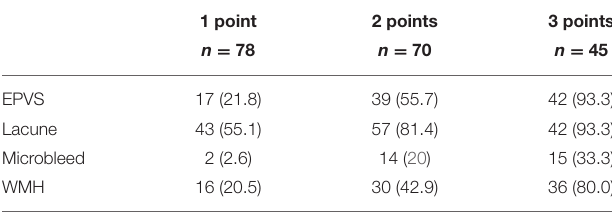
TABLE 2 | Distribution of cSVD markers according to total cSVD score*. 1 point 2